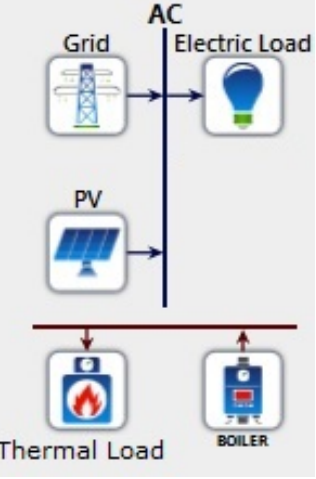
Figure 4. Basic setting of loads and sources in